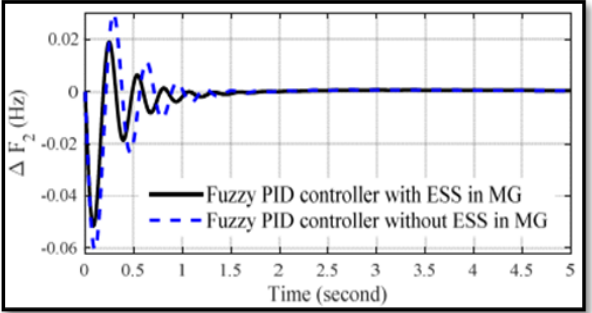
Figure 2. Frequency deviation in area-2 (∆F2) with and without ESS in both